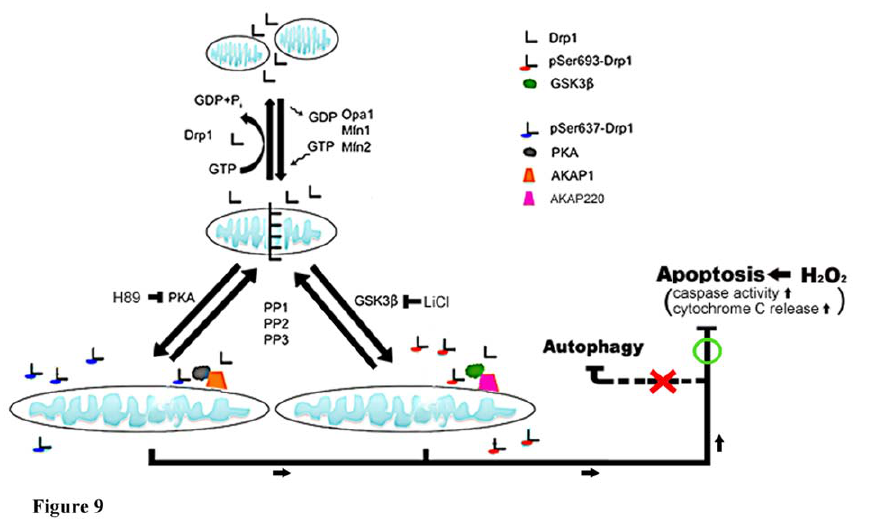
Figure 9. Model represents both GSK3 b - and PKA-mediated Drp1 phosphorylation induction of mitochondrial elongation which subsequently causes acquired resistance to H 2 O 2 -induced apoptosis rather than inducing autophagy. Mitochondria dynamics regulate the GTPase hydrolysis activity of proteins (Drp1, Opa1, Mfn1 and 2) resulting in mitochondrial fission or fusion. In this model, two Drp1 phosphorylation sites could serve a regulatory function, including phosphorylation by PKA/AKAP1 on Ser637 [39] or by GSK3 b on Ser693 (as shown in this study), leading to diminished mitochondrial fission resulting in mitochondrial elongation. GSK3 b might be recruited to mitochondria through AKAP220 and be dephosphorylated by PP1, 2, and 3 [40]. Such mitochondrial morphological changes could also result in cell fate determination. Mitochondrial fission is involved in the initiation of apoptosis, whereas mitochondrial fusion may induce autophagy. Both phosphorylation events occurring at S637 and S693 cause elongated mitochondrial morphology and lead to acquired resistance to H 2 O 2 -induced mitochondrial fragmentation and ensuing apoptosis via down-regulating cytochrome c release, capase-3, -7 and PARP activations rather than inducing autophagy.